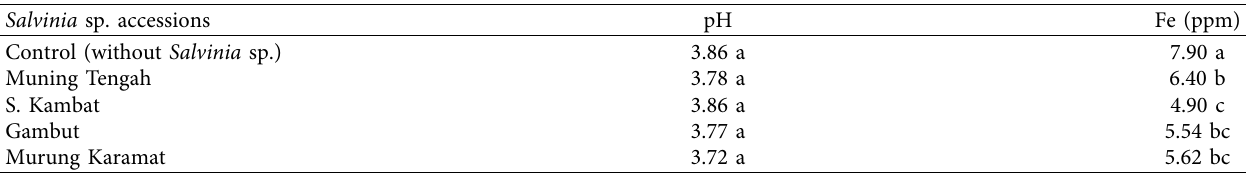
Table 9: The pH and Fe content of surface water in the pot after the culture of Salvinia sp. during 4 weeks in tidal swampland soil growing